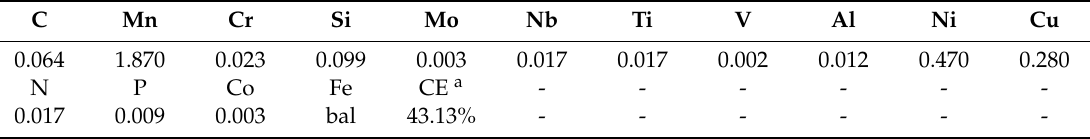
Table 1. Chemical composition and carbon equivalent (CE) of X100 pipeline steel (wt%).